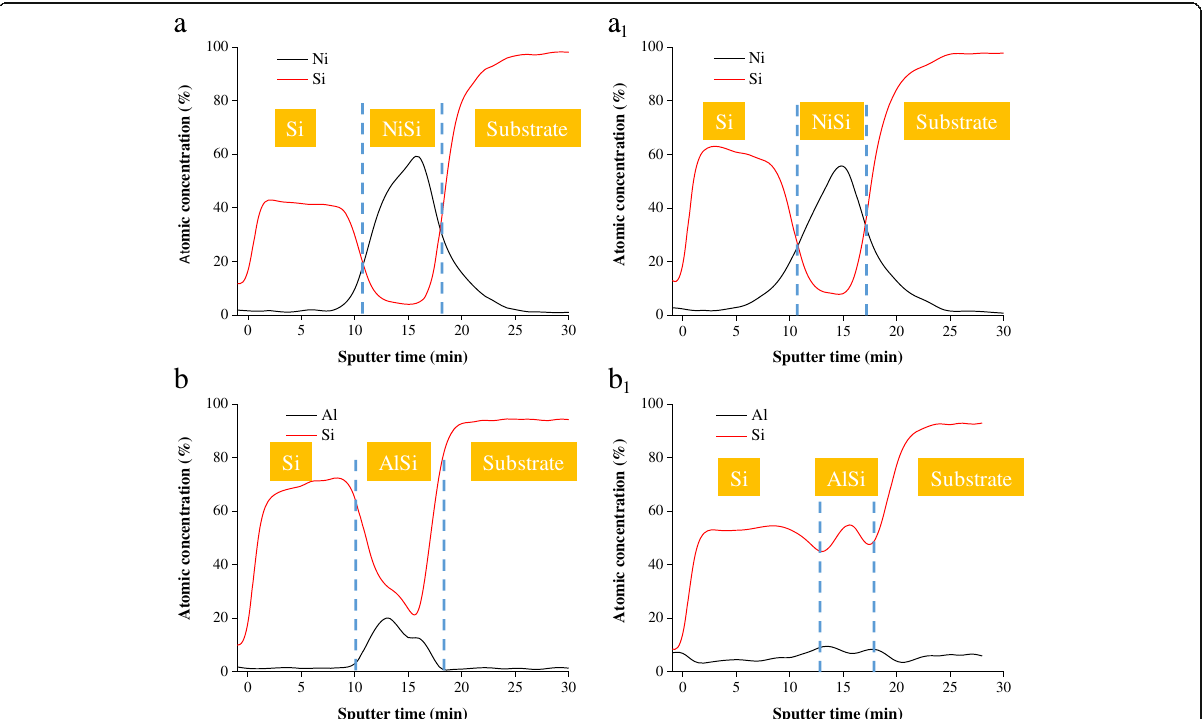
Fig. 4 The depth profile of atomic composition analysis of a , b as-deposited NiSi/Si (NS-1) and AlSi/Si (AS-1) films and a 1 , b 1 those films annealed at 500 °C